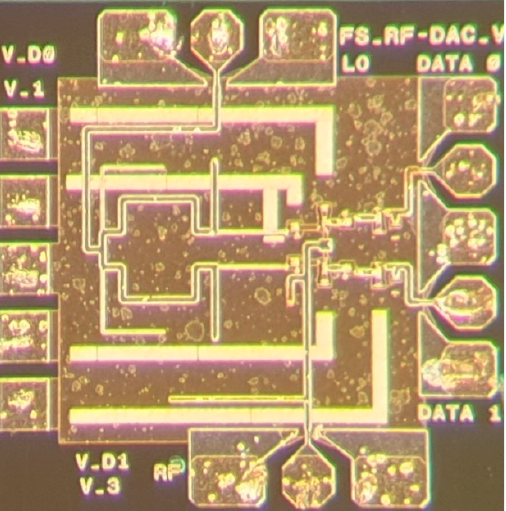
Figure 3. A photo of the fabricated RF-DAC. The chip size including pads is 740 µm by 740 µm. The total size of the MMIC including pads is 0.55 mm 2 , and 0.29 mm 2 without pads. Both the PAM-4 modulator and the PD were designed and simulated using the Keysight Advanced Design System (ADS), in the same InP DHBT process.